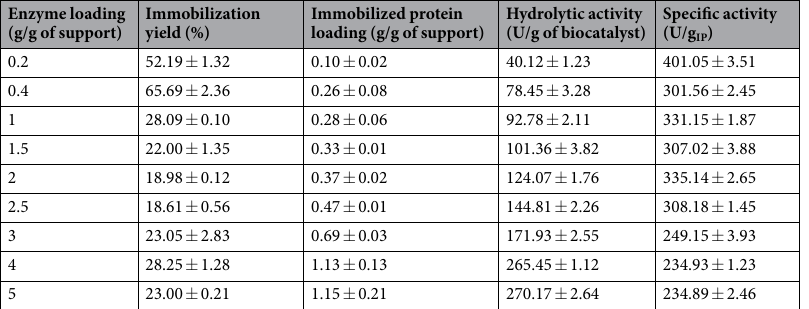
Table 2. Influence of initial graphene protein loading on the catalytic properties of immobilized particle. Reaction condition: Different concentrations of enzyme solution (1, 2, 5, 7.5, 10, 12.5, 15 and 20 g/L) was dissolved by 2 mL disodium hydrogen phosphate-citrate buffer (pH 7); and reaction temperature was 50 °C; the nanoparticles mass was 10 mg; the mixture was stirred at 120 rpm in an incubator shaker for 3